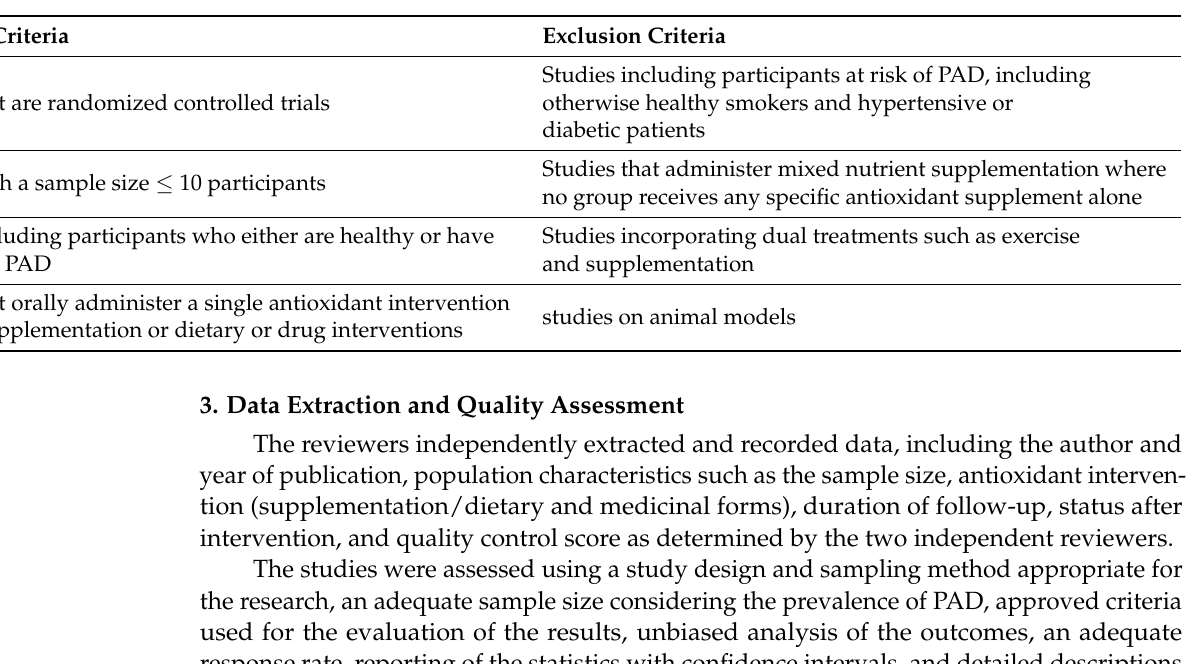
Table 2. Inclusion and exclusion